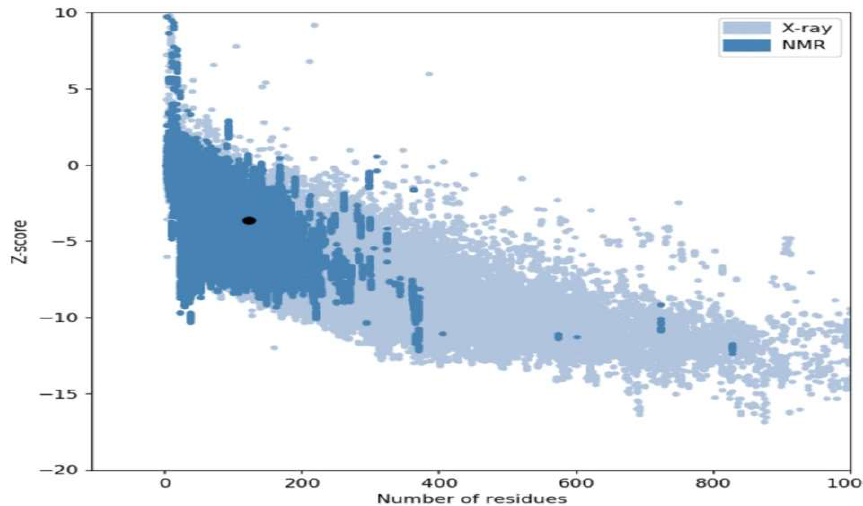
Figure 3. Ramachandran plot for structural validation of drug target protein (DNA-binding response regulator). The most favored zone contains 93.6% of the residues, the additional allowed region contains 6.4%, and the disallowed region contains 0% of the residues. (a = α -helix (right/left handed); B = anti-parallel β -sheet; b = parallel β -sheet; p = proline. The coloring/shading on the plot represents the allowed phi-psi backbone conformational regions, where the darkest areas (in red) correspond to the most favorable combinations of phi-psi values).